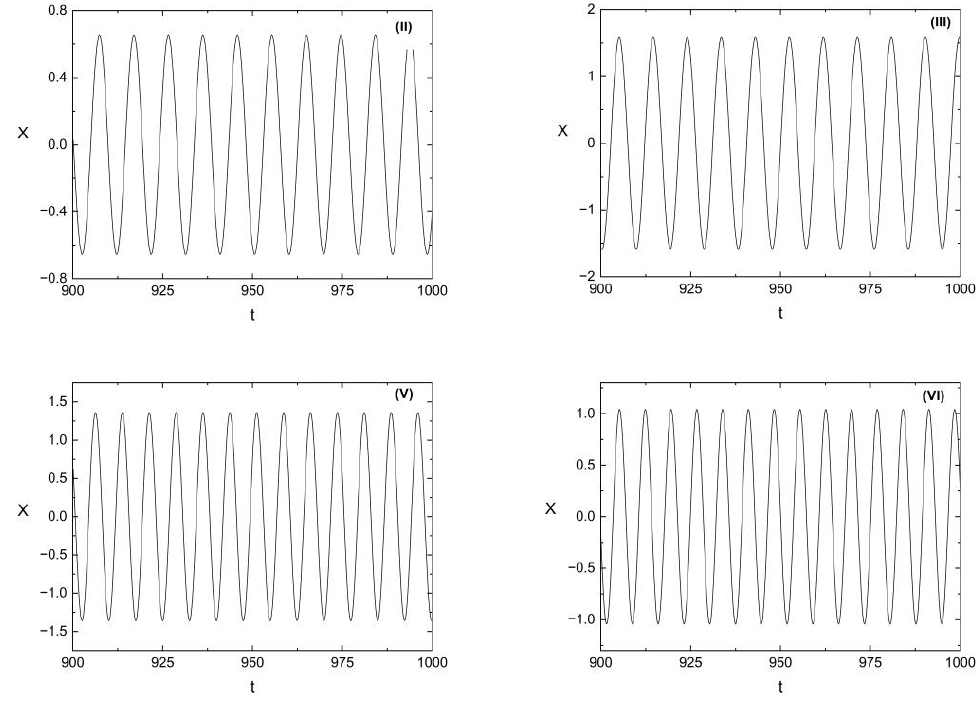
( 1.25,4.31 ) ∈ case ( IV ) .